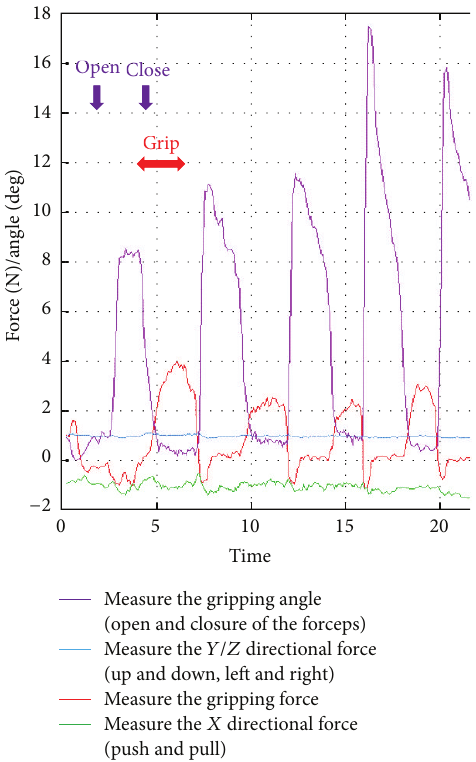
Figure 5: The green line represents the 𝑋 directional force, the red line represents the grabbing force, and the blue line represents the sum of the 𝑌 and 𝑍 directional forces. The angles of the blade are shownasapurpleline,andthemeasurementsaresynchronizedwith the blade opening and closing.